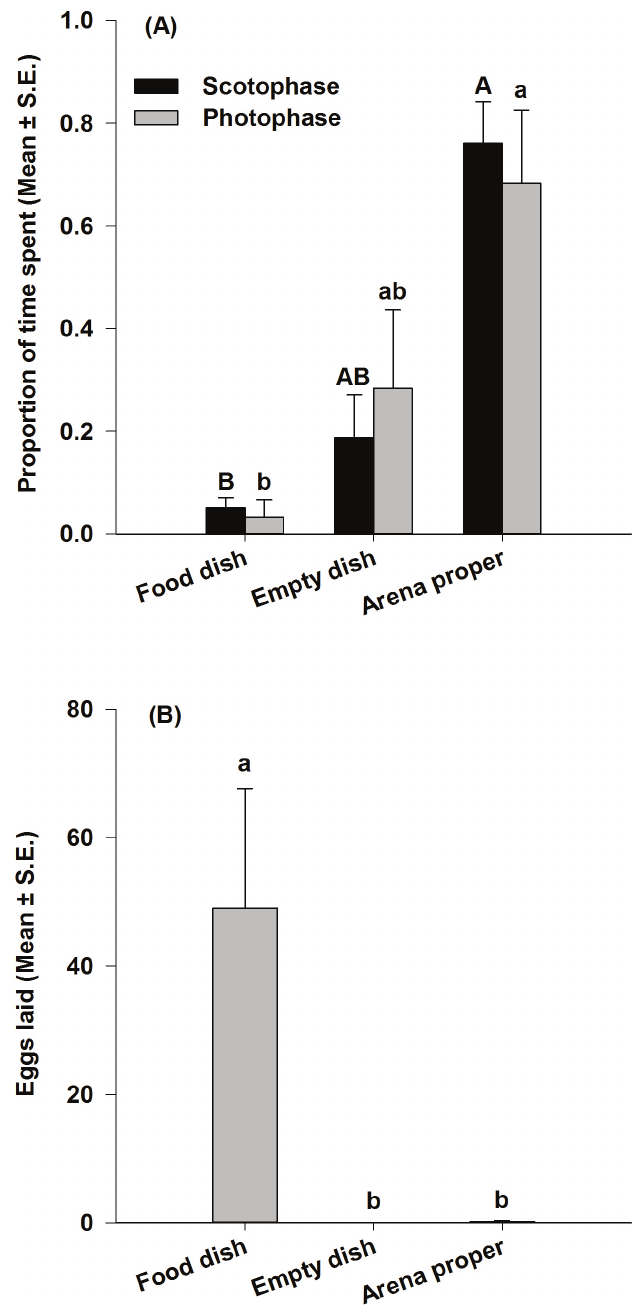
Figure 4. Proportion of time allocated during the scotophase and photophase periods in 48-h assays ( A ); and mean number of eggs laid (±S.E.) by Plodia interpunctella females ( B ) at the three oviposition sites in Study 2. Bars with the same uppercase or lowercase letter are not significantly different ( n = 6; p < 0.01).